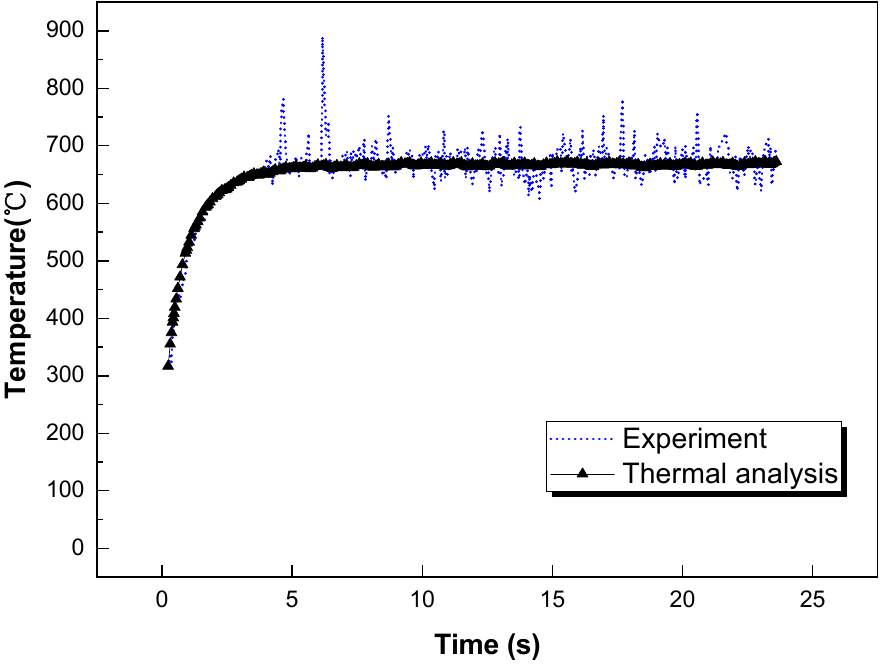
Figure 7. Surface temperature histories of experiment and simulation.